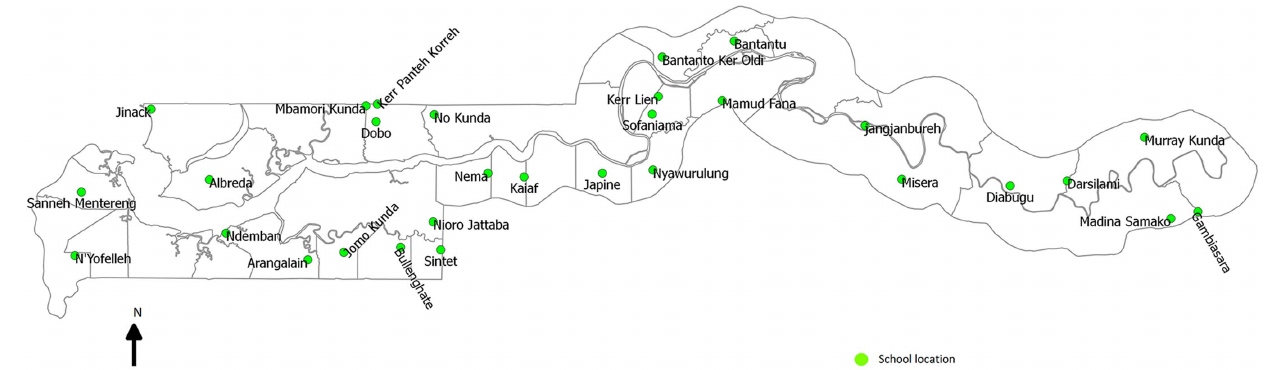
Figure 1. Geographical locations of primary schools sampled in the survey. Circles represent the GPS location of the school.